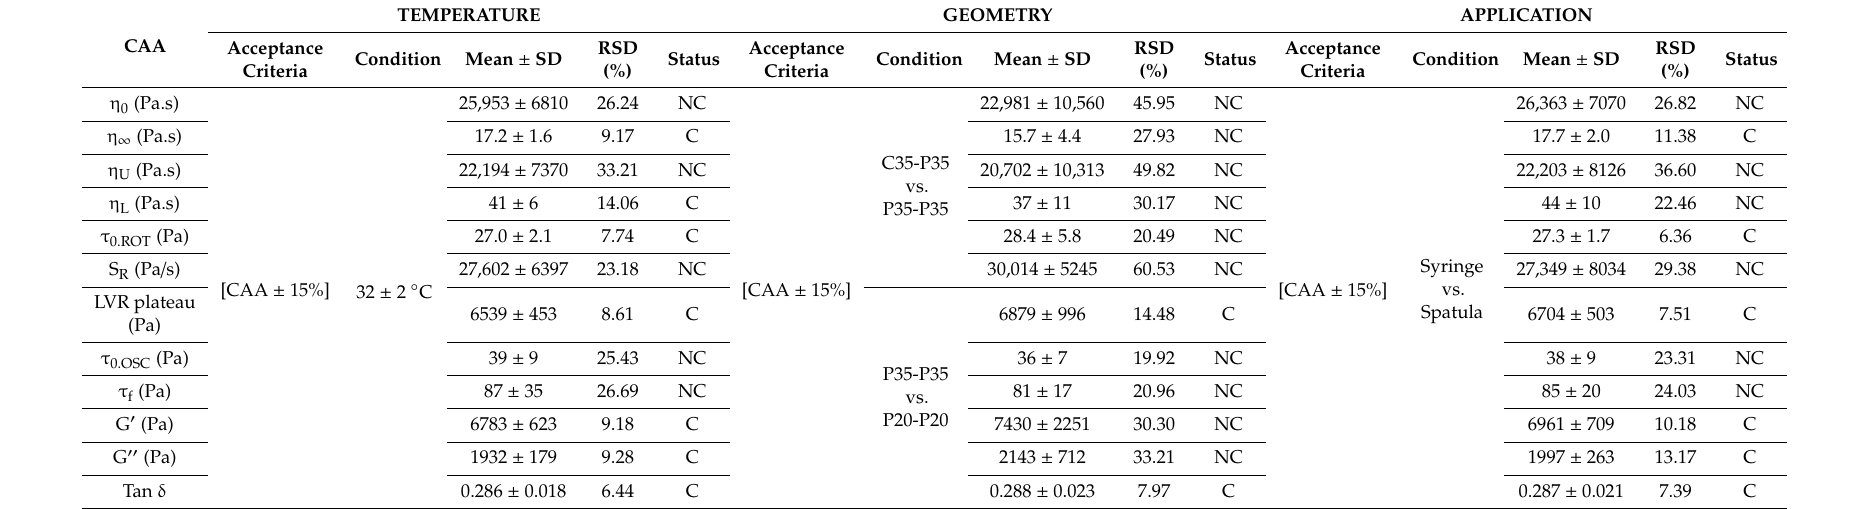
Table 6. Acceptance criteria and results of robustness evaluation for the optimal formulation. Results report to mean ± SD. A n = 12 was used. TEMPERATURE GEOMETRY CAA